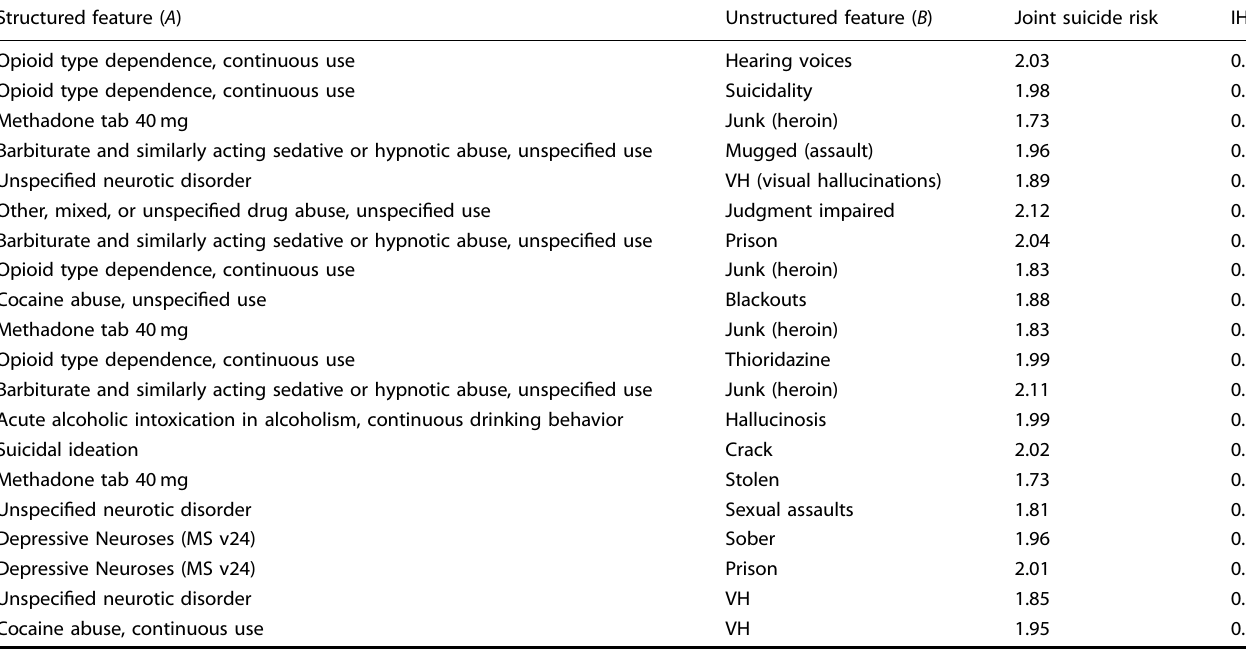
Table 9. Structured-unstructured feature pairs A - B with low interaction heterogeneity (IH) values. Structured feature ( A )